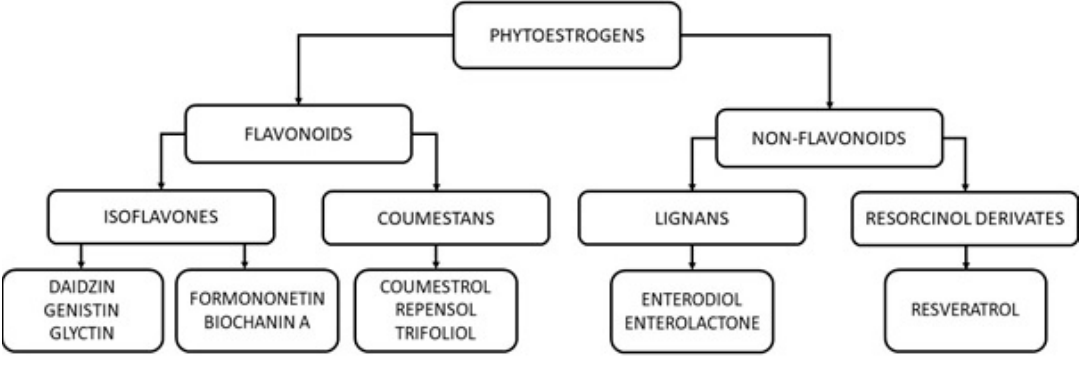
Figure 1. A simplified classification of phytoestrogens.